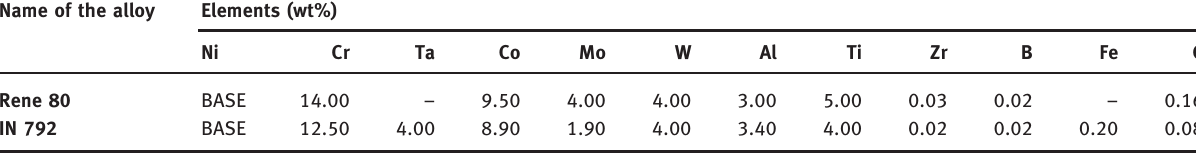
Table 1: Nominal chemical composition of studied alloys given in wt%. Name of the alloy